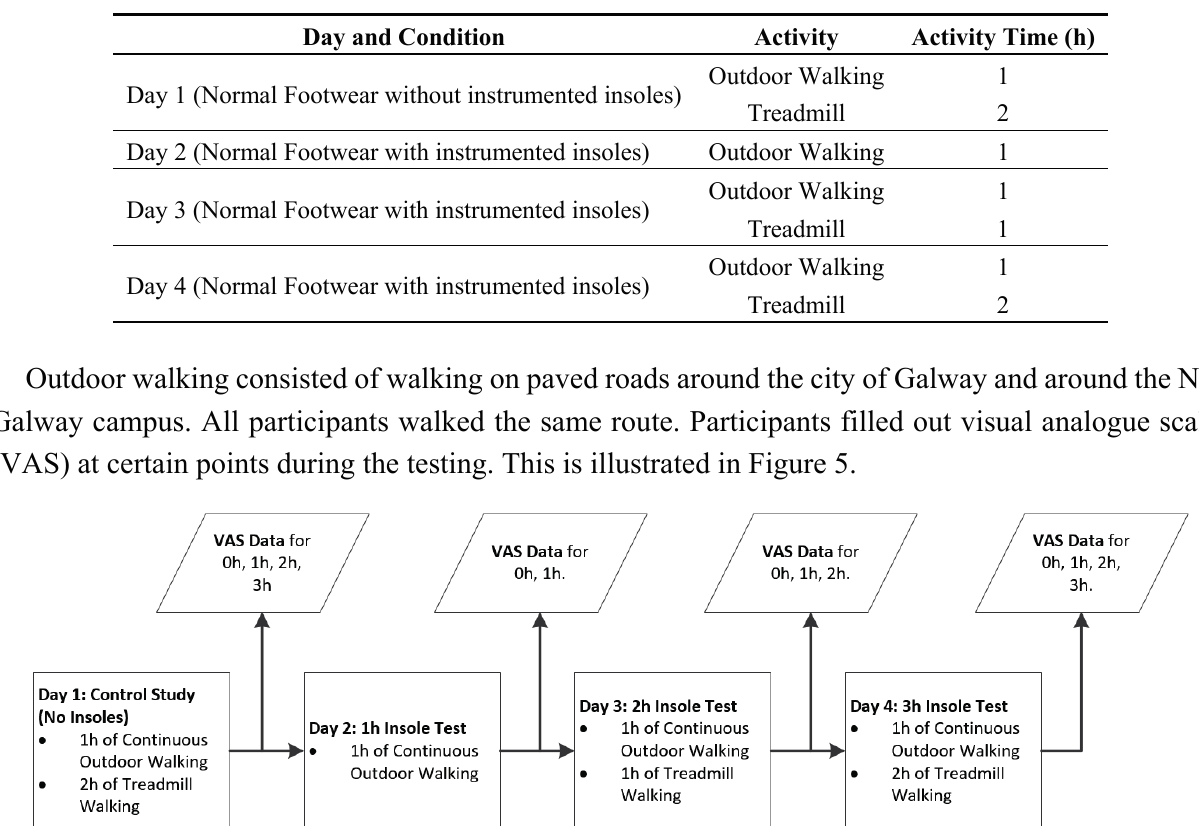
Table 5. Outline of activities carried out by users during user testing.